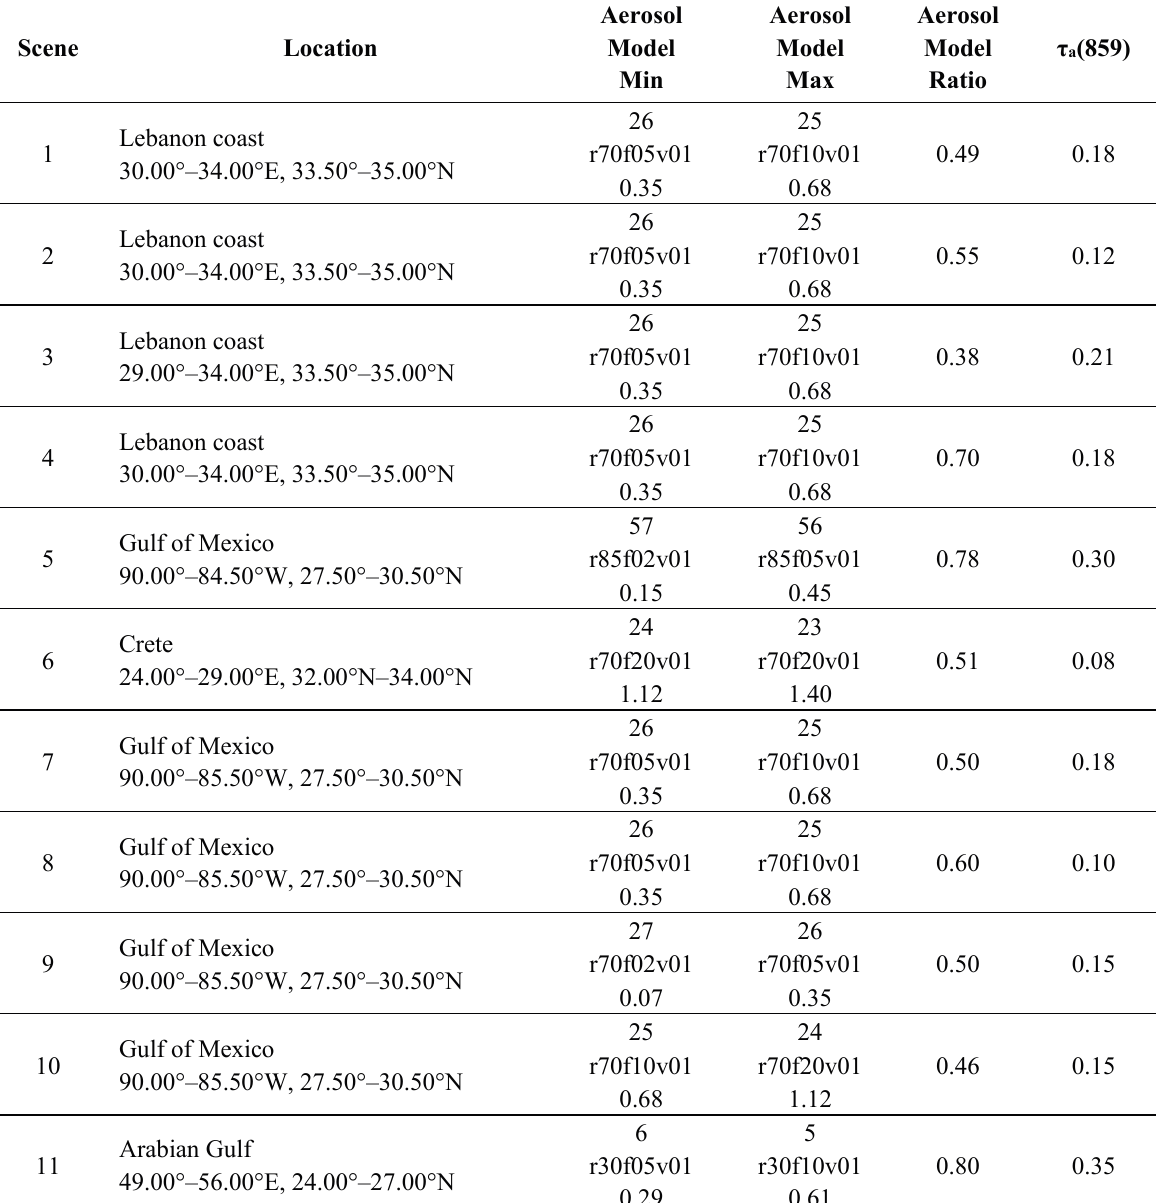
Table 2. Retrieved dominant aerosol models, aerosol model ratio and τ a ( λ = 859 nm) in regions where glitter is negligible for the 11 scenes of Table 1. Aerosol model characteristics are indicated in Columns 3 and 4 (e.g., 26 r70f05v01 0.35 indicates model No. 26 in the current version of SeaDAS, with 70% air column humidity, 5% fine aerosol fraction and the Angstrom coefficient alpha =